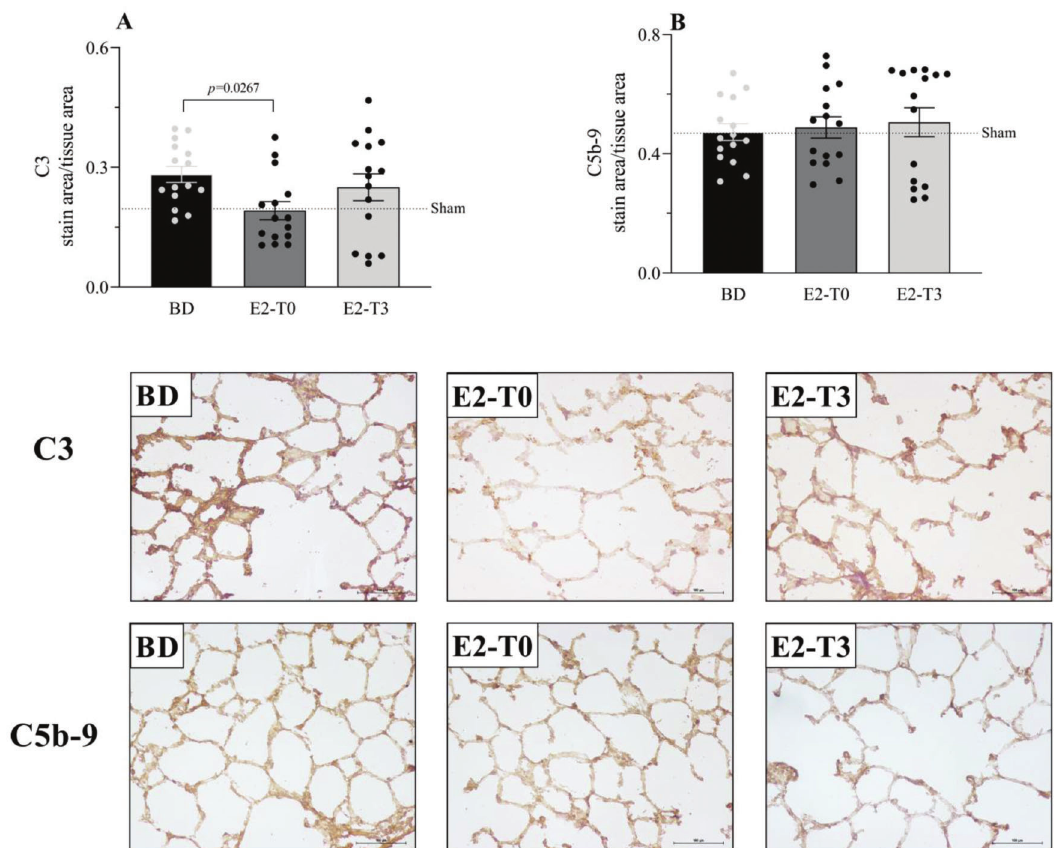
Figure 2 - Complement system C3 (A) and C5b-9 (B) component expression on lung tissue and respective photomicrography of the immunohistochemical reaction. Female rats were separated in groups: sham animals as control, BD animals subjected to brain death (BD), E2-T0 animals subjected to BD and treated with 17 b -estradiol (E2) starting after BD confirmation, and E2-T3 animals subjected to BD and treated with E2 3h after BD confirmation. Data expressed as mean ± SEM from 5 photos/sample, 3 samples/animal, 5 animals/group. Kruskal-Wallis p =0.0442 (A) and p =0.8881 (B).